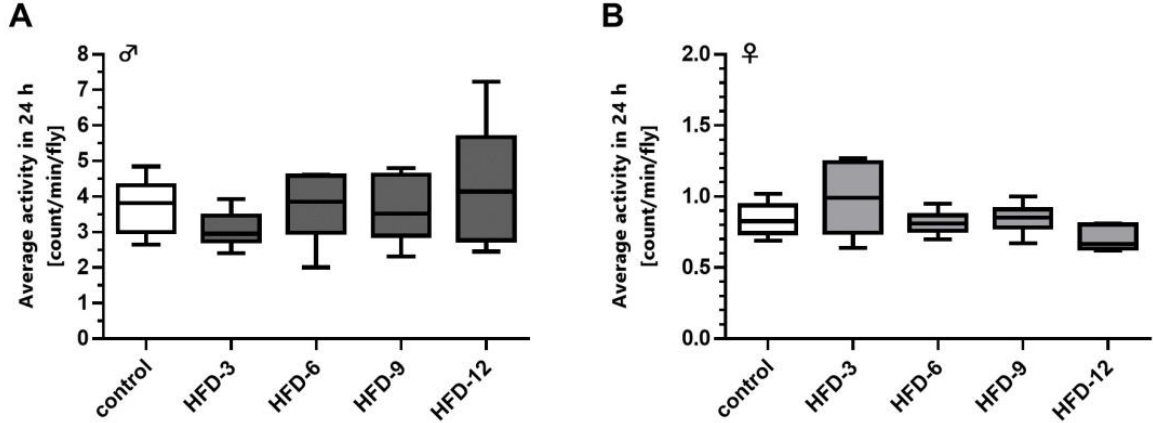
Figure 3. Short-term exposure to high-fat diets (HFD) comprising 3% to 12% ( w / v ) butterfat (BF) did not affect the spontaneous locomotion activity of male and female D. melanogaster. D. melanogaster w 1118 were fed ad libitum with a sugar yeast control diet or HFD comprising 3%, 6%, 9%, 12% ( w / v ) BF for 5 days under standard condition, before the spontaneous activity was recorded with the Dro- sophila Activity Monitoring system at intervals of 10 min after an adaptation period of 24 h. ( A ) At none of the concentrations applied did BF significantly alter the spontaneous activity in males and ( B ) females ( n = 3 replicates; N = 120 flies per treatment in total. Data are shown as boxplots with whiskers indicating minimal and maximal values. Statistical significance was evaluated by ANOVA. HFD-3: high-fat diet with 3% ( w / v ) BF, HFD-6: high-fat diet with 6% ( w / v ) BF, HFD-9: high-fat diet with 9% ( w / v ) BF, HFD-12: high-fat diet with 12% ( w / v ) BF.